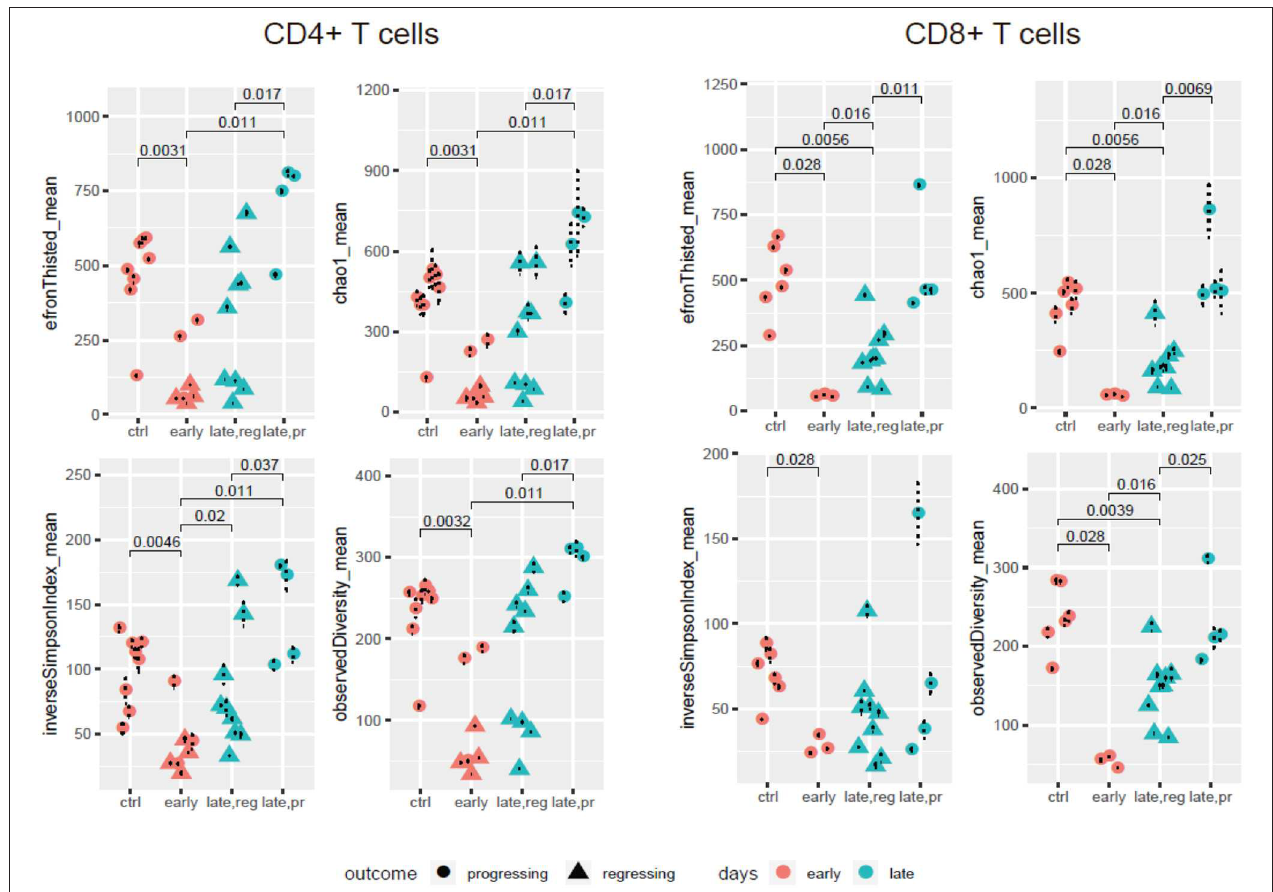
FIGURE 2 | TCR repertoire diversity in the course of anti-PD-1 therapy. Diversity metrics calculated for CD4 + and CD8 + TCR α + β (combined) CDR3 repertoires extracted from the four groups of samples: control; early response (day 14); late response, regressing (days 17 and 24); and late response, progressing (days 17 and 24). Each sample is represented by 500 randomly chosen CDR3-covering sequencing reads, for